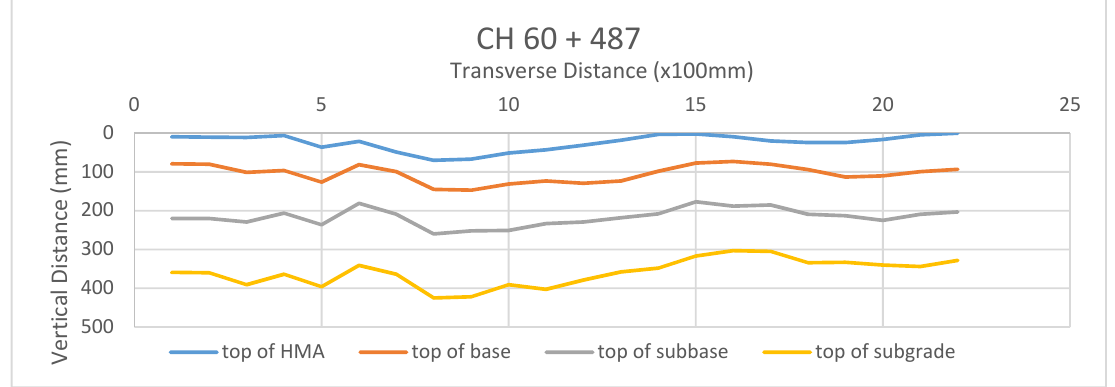
Figure 17. Profile of trench measurements of 60 + 487 km.